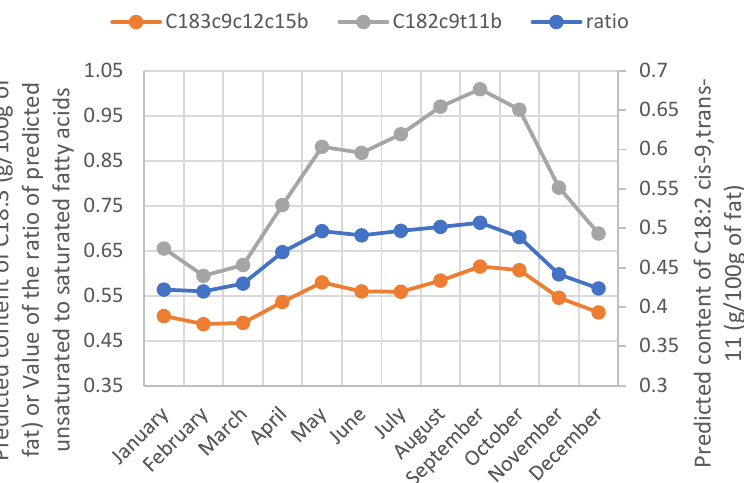
Figure 2. Yearly evolution of the ratio of predicted unsaturated to saturated fatty acids and the predicted content of C18:2 cis-9, trans-11 and C18:3 cis-9, cis-12, cis-15 in milk fat.